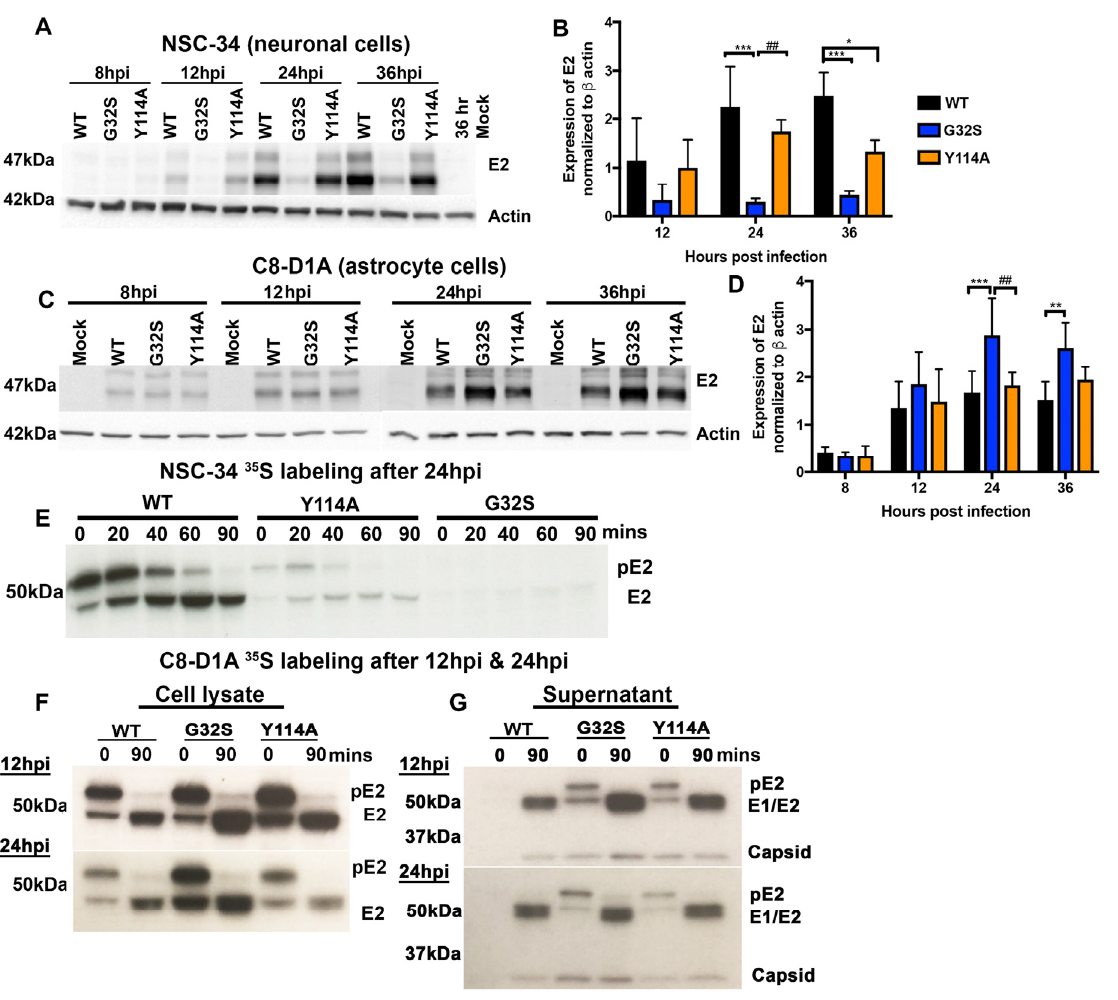
Figure 5. The G32S nsP3 MD mutation that affects both ADPr binding and hydrolase functions differentially affects structural protein synthesis by NSC-34 neuronal and C8-D1A astrocytic cells. NSC-34 and C8-D1A cells were infected with CHIKV WT, G32S, and Y114A at an MOI of 5. Representative immunoblots ( A ) and densitometry quantification ( B ) data on lysates from infected NSC-34 cells probed with antibodies to E2 glycoprotein and β -actin at 12, 24, and 36 h from Abraham et al., 2018 [53]. Representative immunoblots ( C ) and densitometry quantification ( D ) of lysates from infected C8-D1A cells probed with antibodies to the E2 glycoprotein and β -actin at 8, 12, 24, and 36 h. The averages from four independent experiments +/ − SD are plotted as a bar graph. * p < 0.05; ** p < 0.01, *** p < 0.001 compared to WT; ## p < 0.01 G32S compared to Y114A. For analysis of pE2 processing, cells were pulsed with 35 S-methionine at 12 hpi and/or 24 hpi and chased for 90 min. Cell lysates were immunoprecipitated with antibody to E2 then subjected to polyacrylamide gel electrophoresis, fixed, dried, exposed to X-ray film, and developed. Representative images from pulse-chase analyses of infected NSC-34 ( E ) and C8-D1A ( F ) cells. Pulse-chase analysis of NSC-34 cells was performed once. The image for C8-D1A cells is representative of three independent experiments. ( G ) PEG-precipitated virions from 12 and 24 h pulse-chase C8-D1A cell supernatant fluids (panel E) were subjected to polyacrylamide gel electrophoresis, fixed, dried, exposed to X-ray film, and developed. Image is representative of three independent experiments.